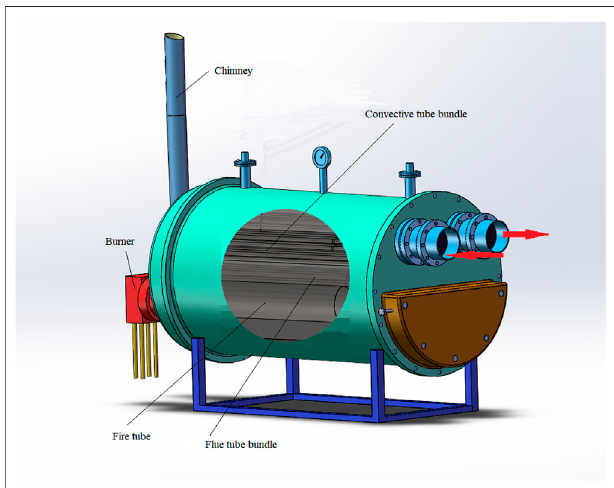
FIGURE 1 | Sketch of a gas